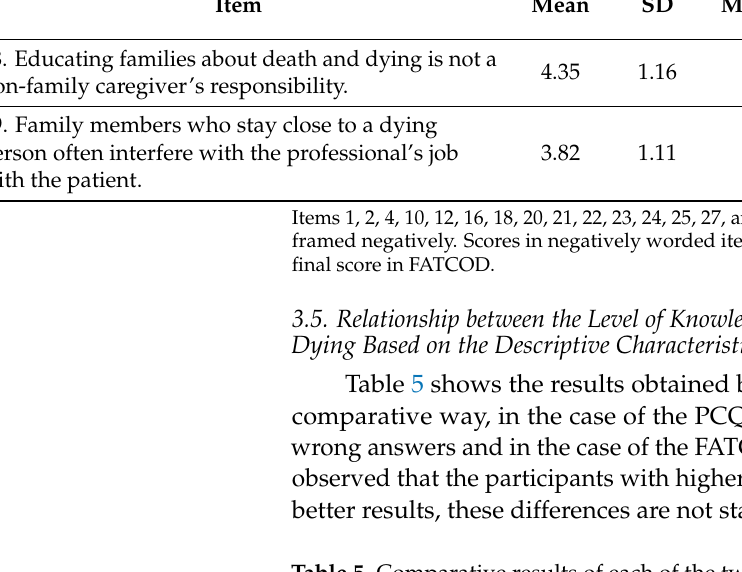
Table 5. Comparative results of each of the two scales according to the population’s